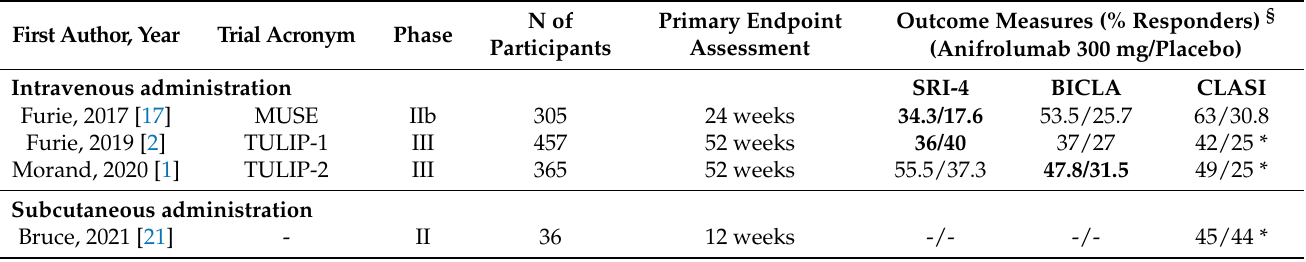
Table 1. Overview of clinical trials of anifrolumab in non-renal Systemic Lupus